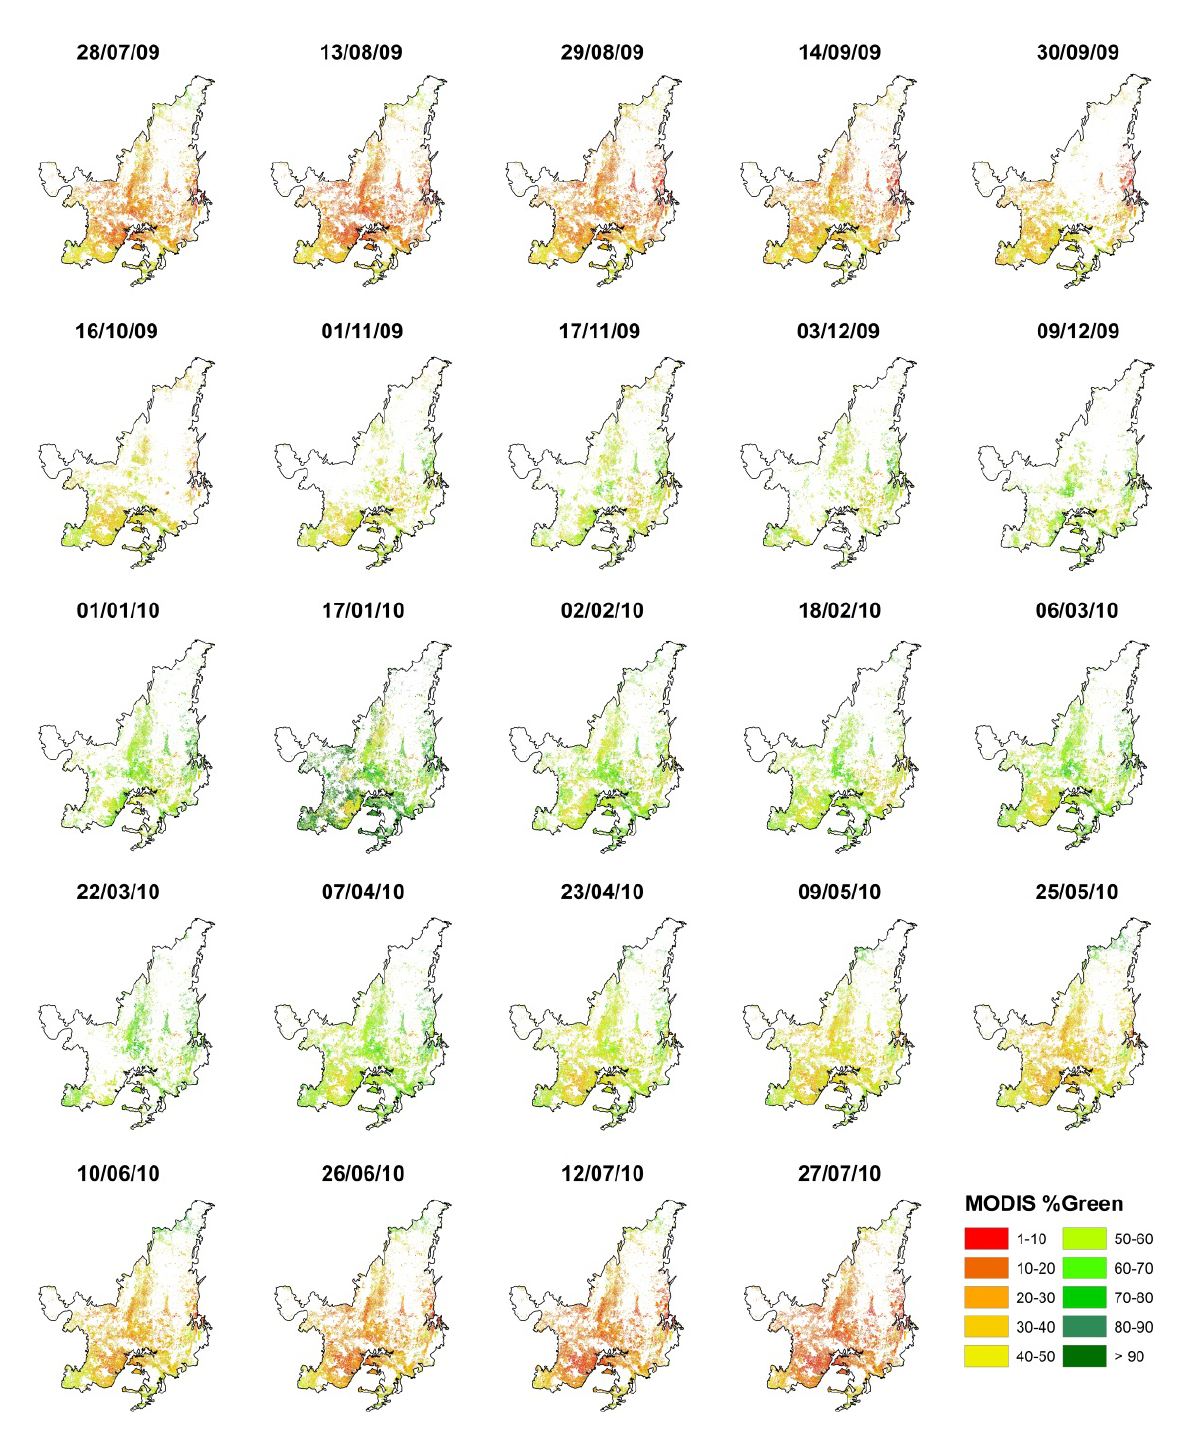
Figure 7. MODIS-based % green cover images for the 2009–2010 hydrological